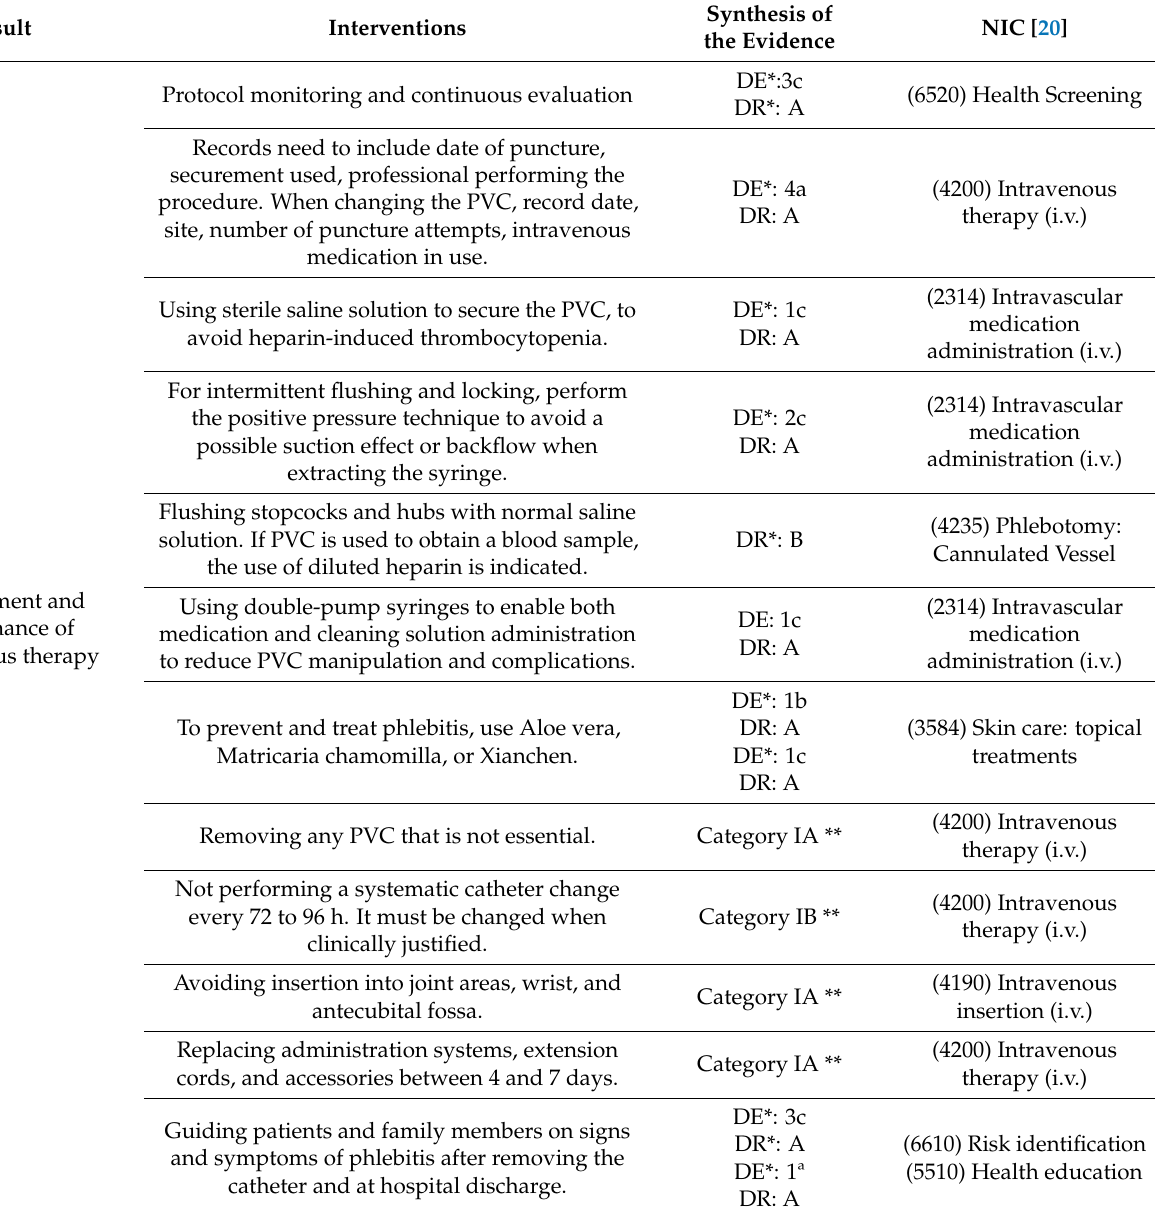
Table 4. Correspondence with NIC interventions and DE and DR analysis with JBI. Result